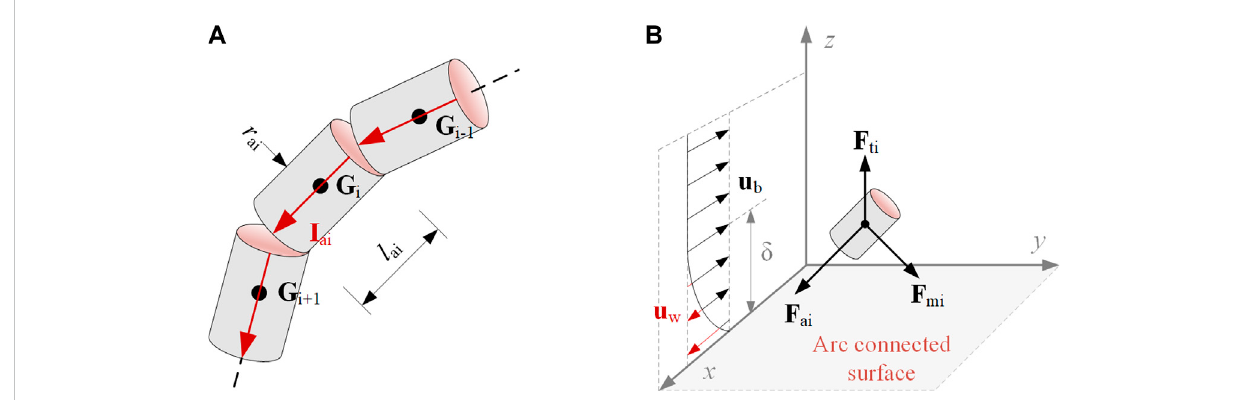
FIGURE 1 Arc chain model and force analysis of the current element, where (A) refers to discreted elements of arc column and (B) represents the spatial force of the ith